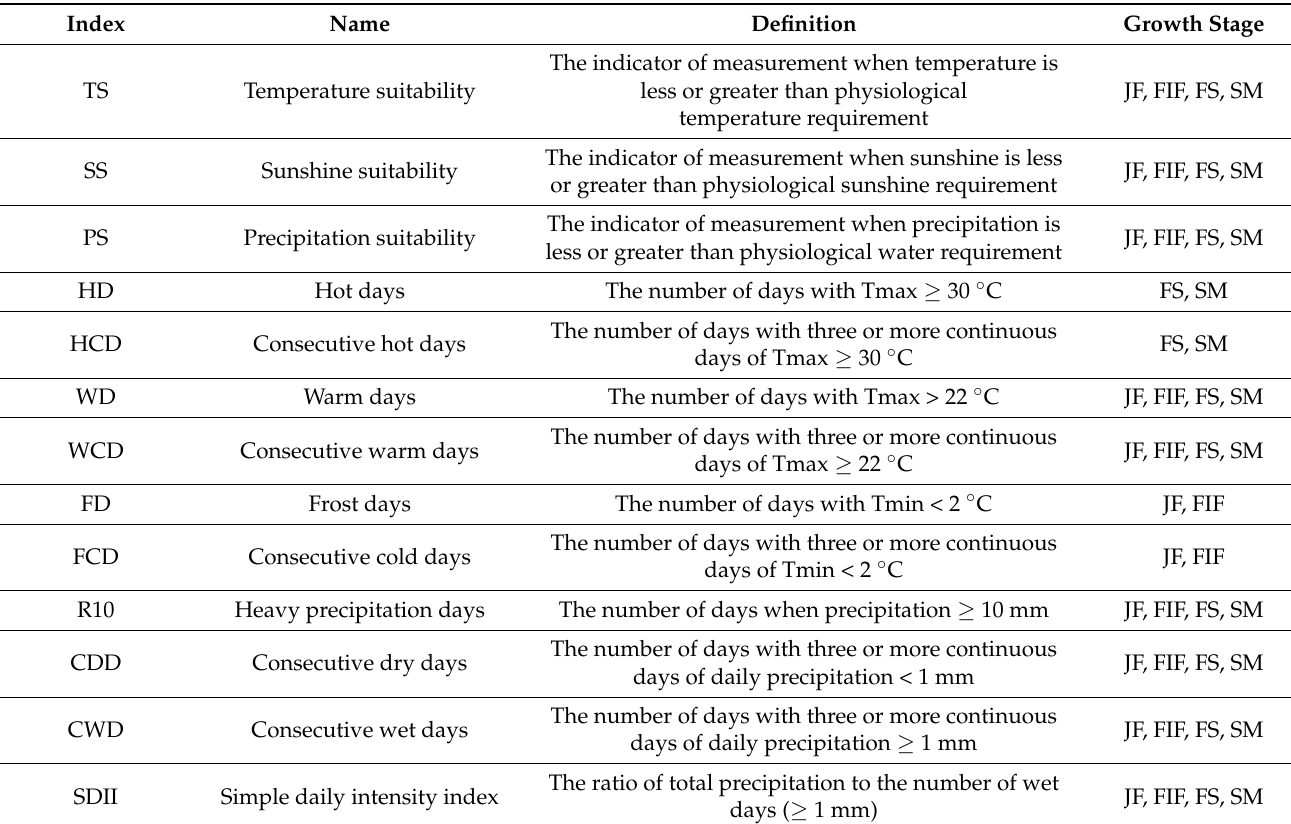
Table 2. The information about the thirteen climate indices (CIs) used in the